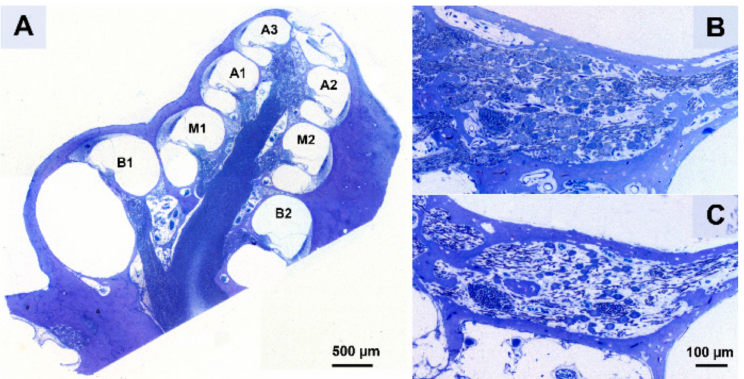
Figure 4. ( A ) A cross-section along a standardized midmodiolar plane. From this cross-section, the spiral ganglion cells (SGCs) within Rosenthal’s canal were quantified for the seven cochlear regions B1–A3. ( B ) An example of Rosenthal’s canal in B1 from a normal-hearing animal (NH) and ( C ) a six weeks deaf untreated animal